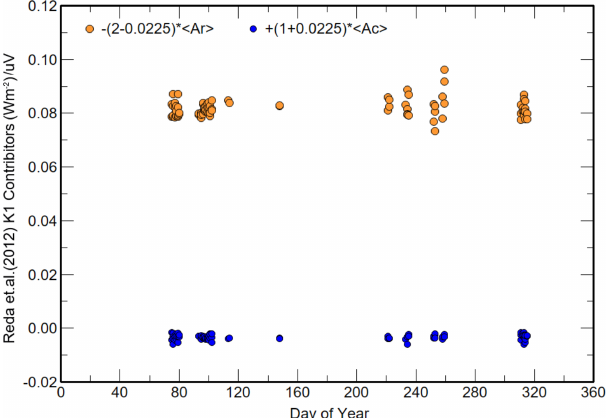
Figure 13. The comparison of <W atm > derived from the new and Reda et al. (2012) equations to the mean IRIS4 irradiances for each linear LSQ calibration period in